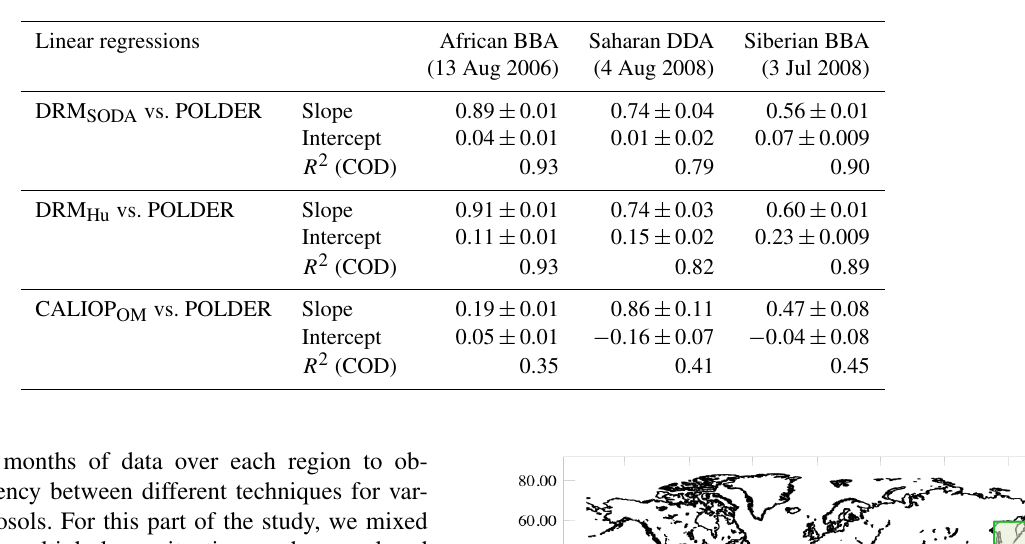
Table 1. Linear regressions of AOT calculated between different methods for three case studies: African biomass-burning aerosols (BBA), Saharan dust aerosols (DDA) and Siberian BBA. R 2 represents the coefficient of determination (COD) between the two sets of data.